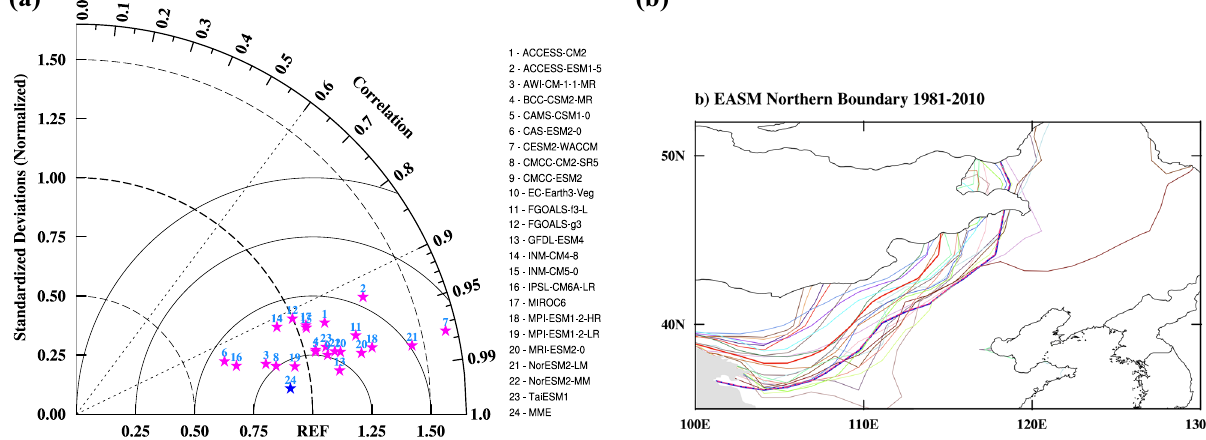
Figure 1. ( a ) Taylor diagram showing the pattern correlation coefficient and normalized standardized deviations in the present day (1981–2010) simulation of the climatological summer precipitation over East Asia (4°N-53°N, 73°E-150°E) of CMIP6 models. ( b ) Climatological distribution of the EASM northern boundary over eastern China for 1981–2010 by using multi-model ensemble (MME, red thick line), bias-corrected MME (blue thick line), GPCP (pink dash line) and 23 CMIP6 model outputs (other color thin lines) data. Maps were generated using the NCAR Command Language (The NCAR Command Language (Version 6.6.2) [Software]. (2019). Boulder, Colorado: UCAR/NCAR/CISL/TDD. https:// www. ncl. ucar. edu/ Downl oad/).